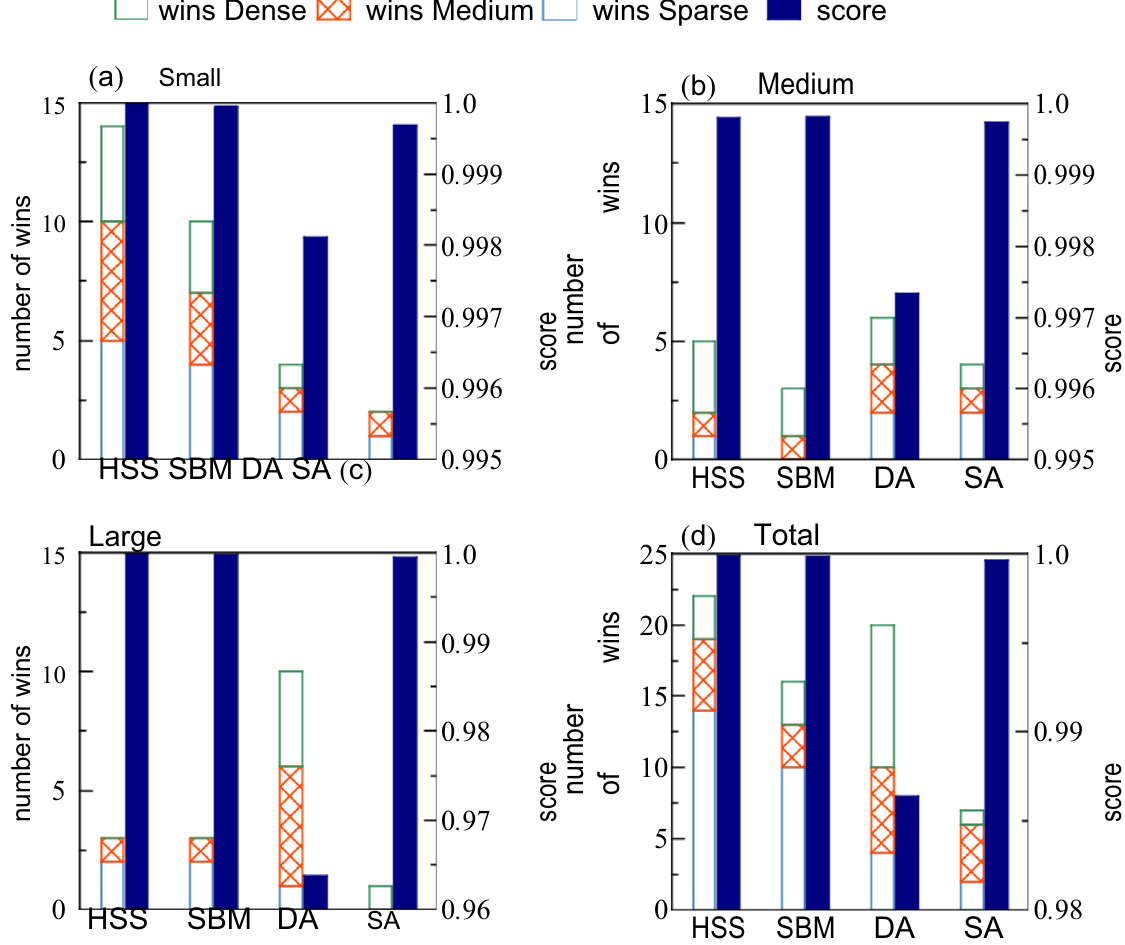
Figure 1. Number of wins (left axis) and average score (right axis) for a 5-min experiment of MQLib instances. Each panel shows the result for a class categorized by problem size, ( a ) Small, ( b ) Mediun, and ( c ) Large; ( d ) Total number of wins and average score for all instances. The score for each instance is defined by Eq. (4). In calculating the average score, instance g000644 was ignored due to absence of data for